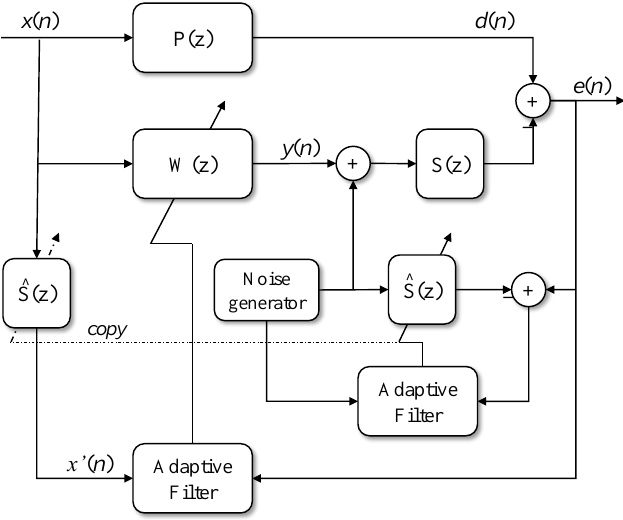
Figure 1. Block diagram of the basic functioning of an adaptive vibration control